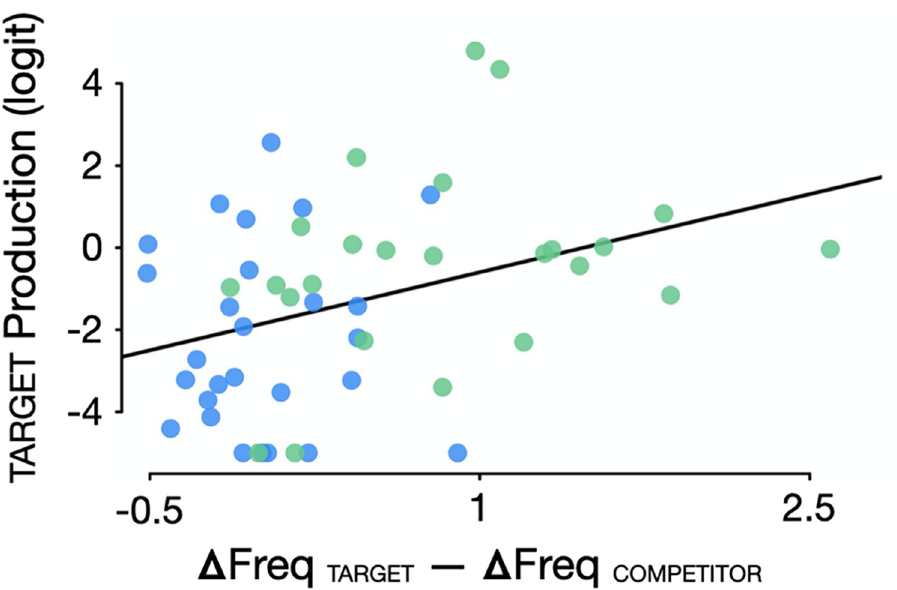
Fig 3. The more the frequency of a TARGET word (e.g., mask or map ) increased from 2019 to 2020 relative to its COMPETITOR ( task or tap ) (x-axis), the more participants perceived the TARGET word relative to its COMPETITOR when replaced by noise (y-axis) ( r (49) = .33, p = .016). Each dot represents one stimulus: Green dots represent COVID word pairs and blue dots represent CONTROL word